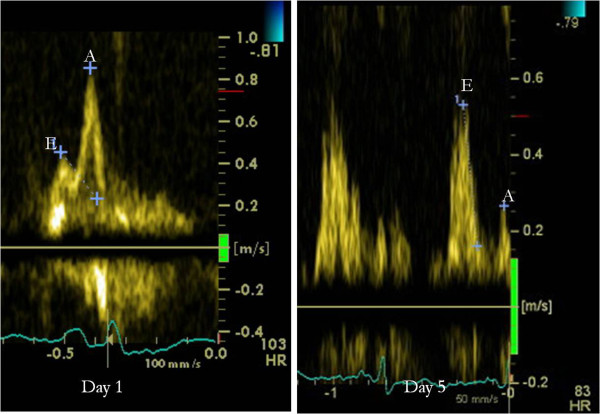
Echocardiogram mitral inflow pulsed wave Doppler showing reversal of E/A ratio indicating a restrictive pattern of filling at day 5.